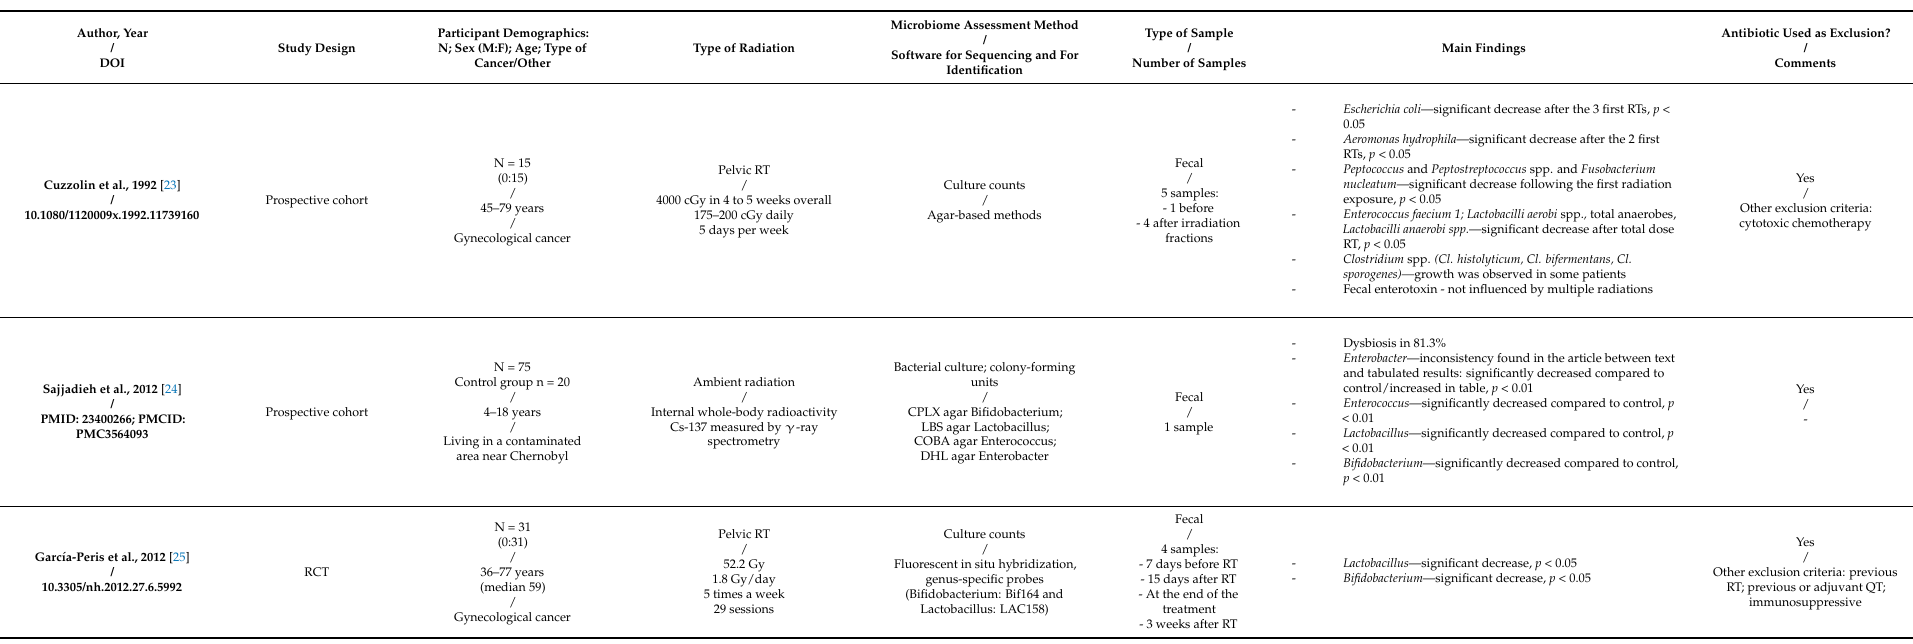
Table 4. Summary of study characteristics, demographics, radiation type, sample collection and analysis, and main findings of the eligible studies